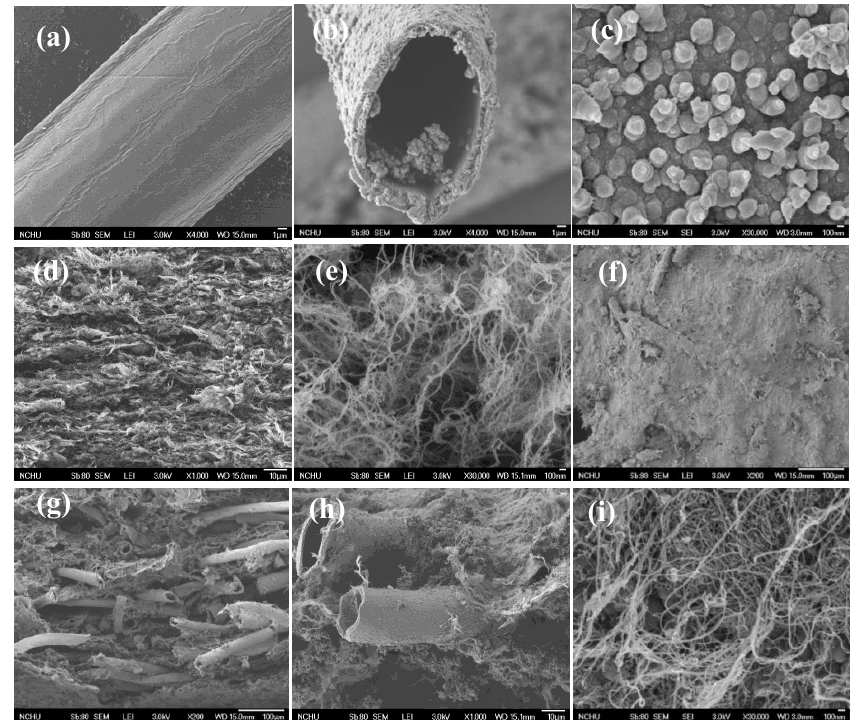
Figure 3. SEM images of ( a ) the pretreated KF; ( b , c ) KF@PPy at ( b ) low and ( c ) high